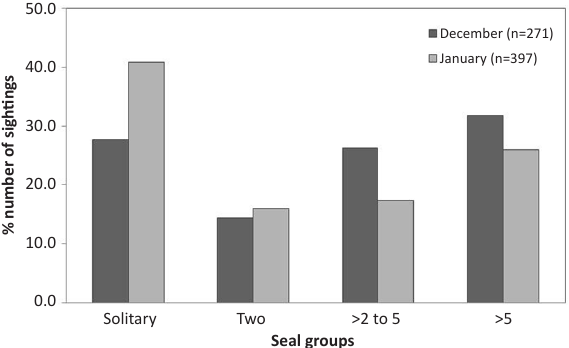
Figure 1. The percentage distribution of different seal groups observed in the Prydz Bay during December 2009 and